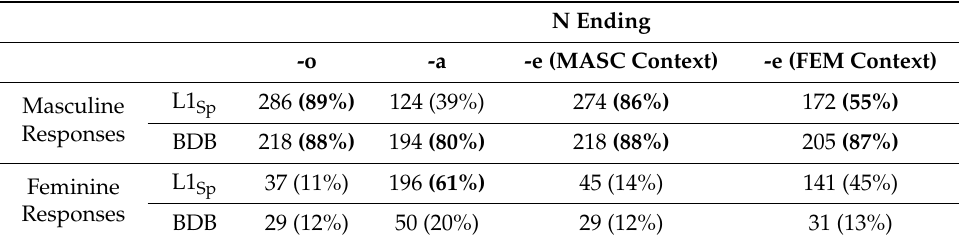
Table 5. Distribution of participants’ MASC form responses, by ending.